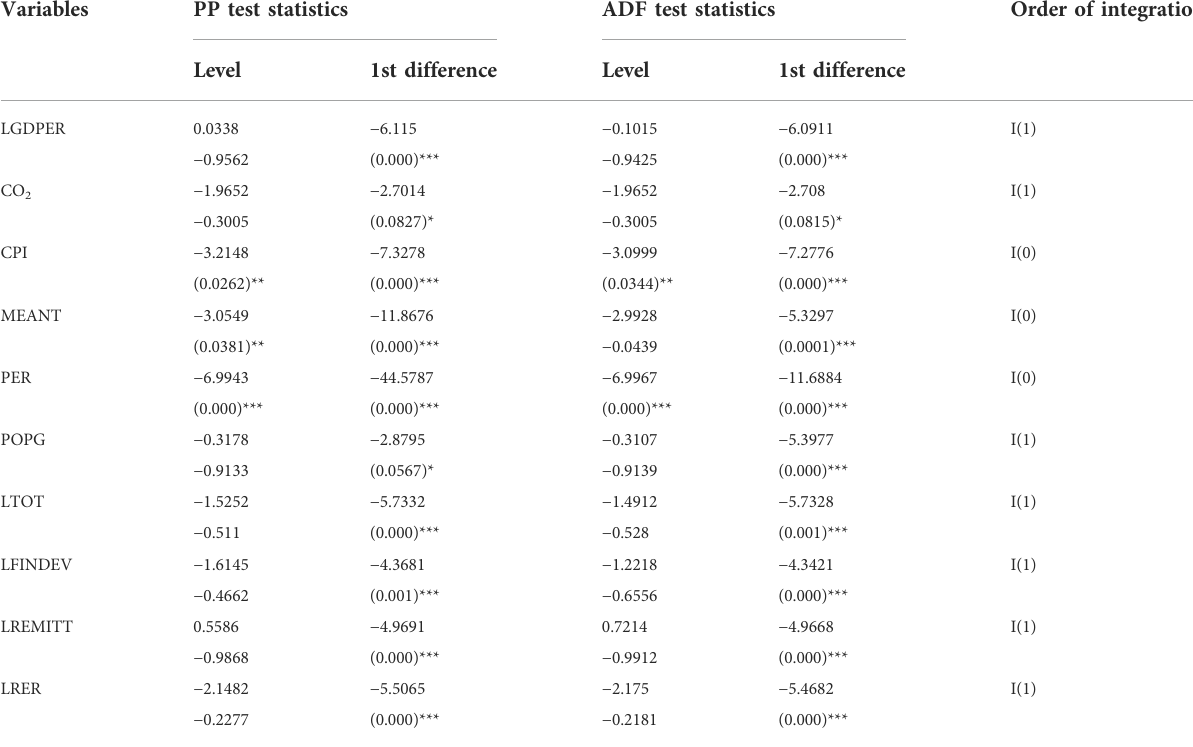
TABLE 2 Results of PP and ADF test.